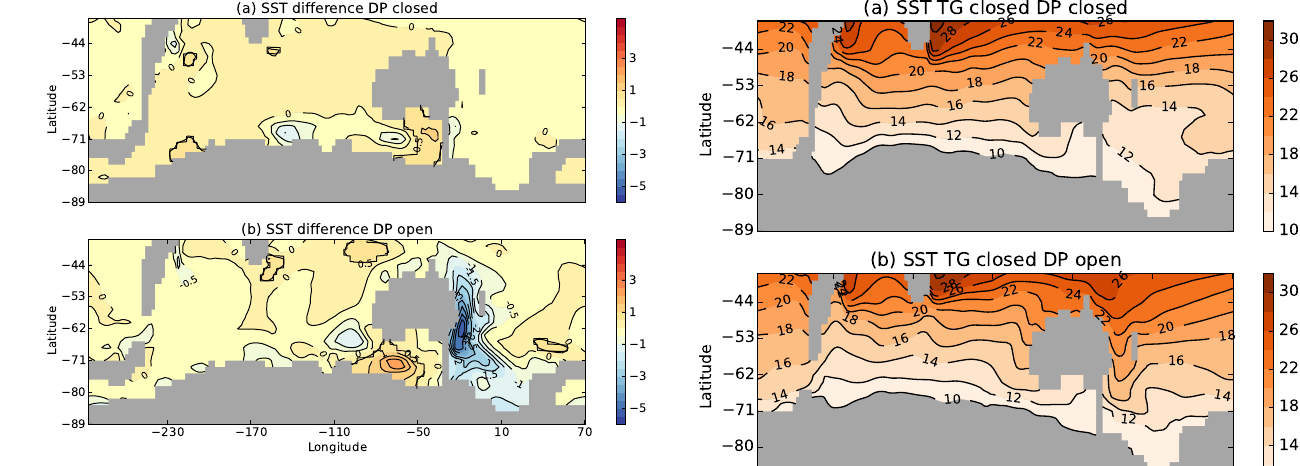
Figure 7. Sea surface temperature change in response to opening the Tasman Gateway (TG). Difference between TG open and TG closed for (a) the Drake Passage (DP) closed and (b) the DP open during the opening of the TG. The opening of the TG leads to a maximum of around 4.0 ◦ C localized surface ocean cooling to the east of Australia only when the DP is open.